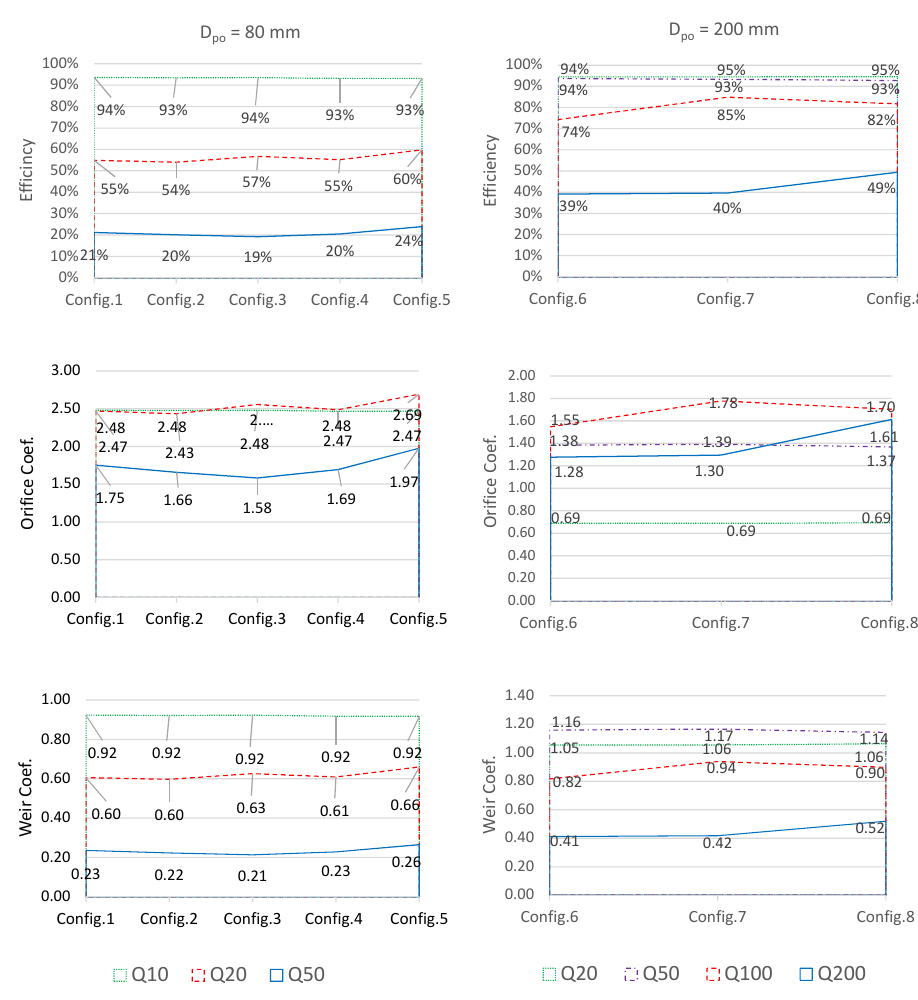
Figure 5. Efficiency and Discharge Coefficients maps for D op = 80 mm (Config. 1 to 5) and D op = 200 mm (Config. 6 to